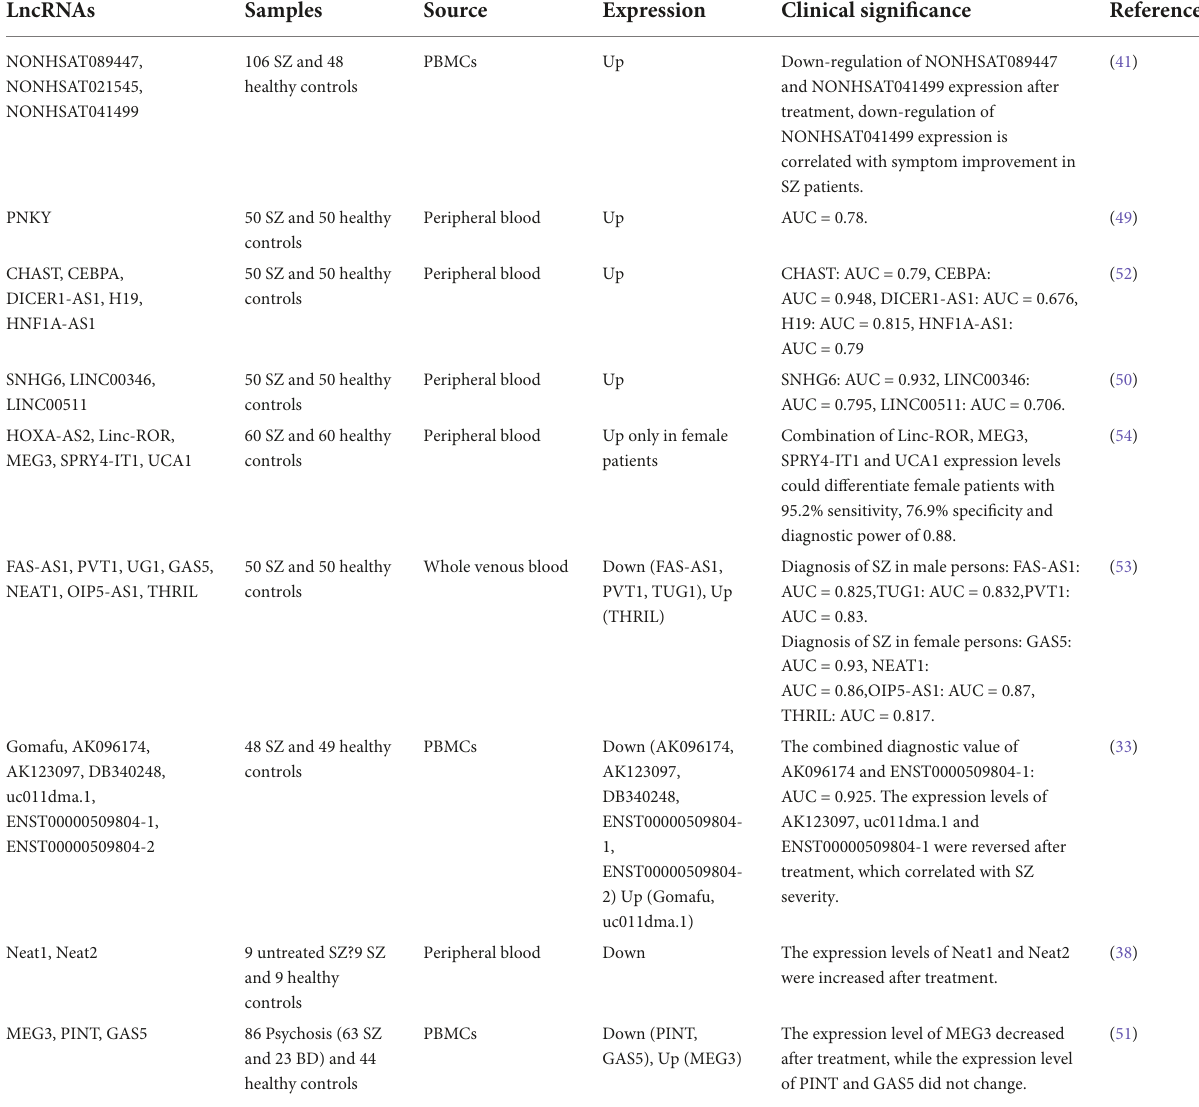
TABLE 2 LncRNAs expression as biomarkers in